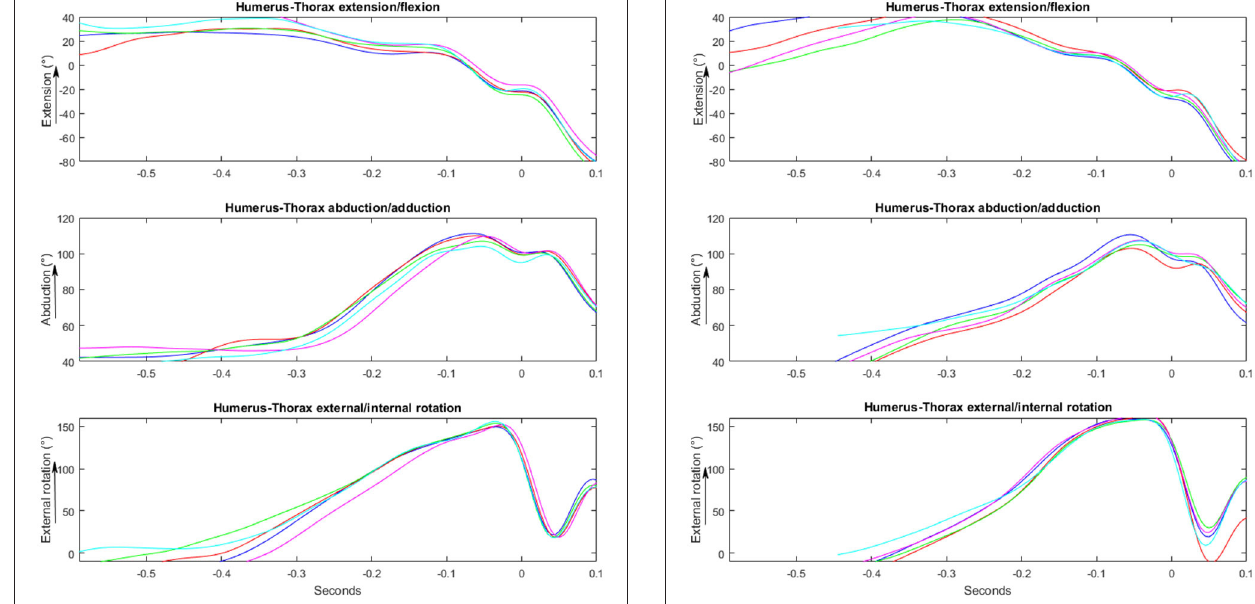
used to define local coordinate systems (LCS) for each segment.